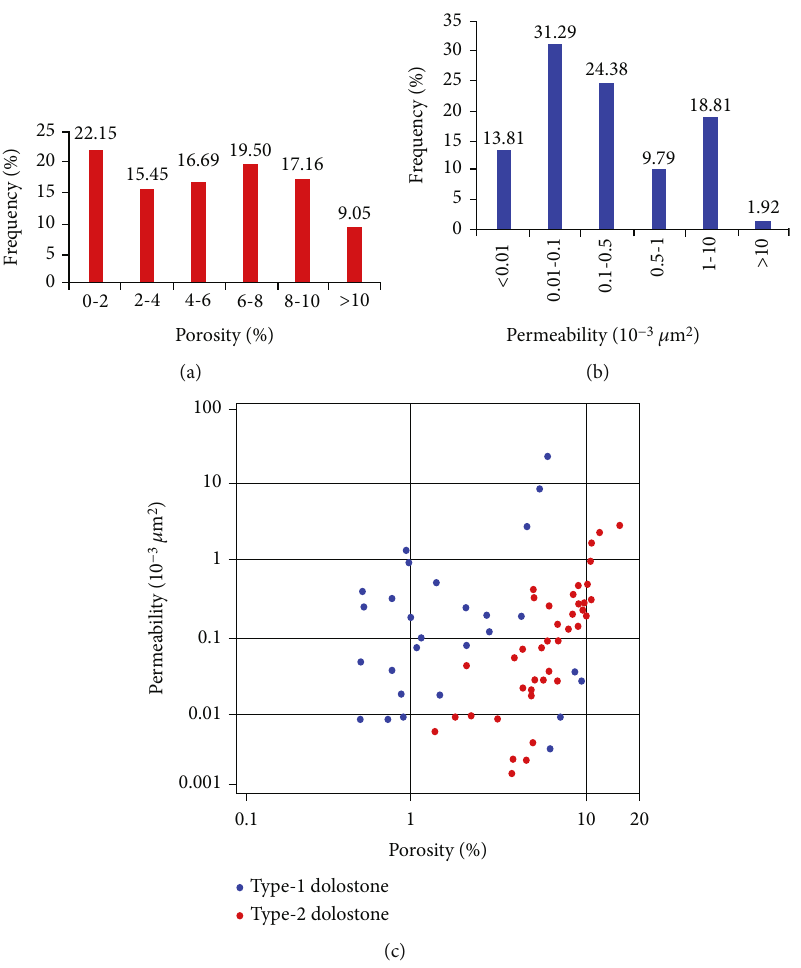
Figure 5: Physical property of dolostone reservoir for submember Ma5 porosity; (b). Frequency distribution of permeabilty; (c). Plot of porosity versus permeability). Table 1: Element compositions of the dolostones from submember Ma5